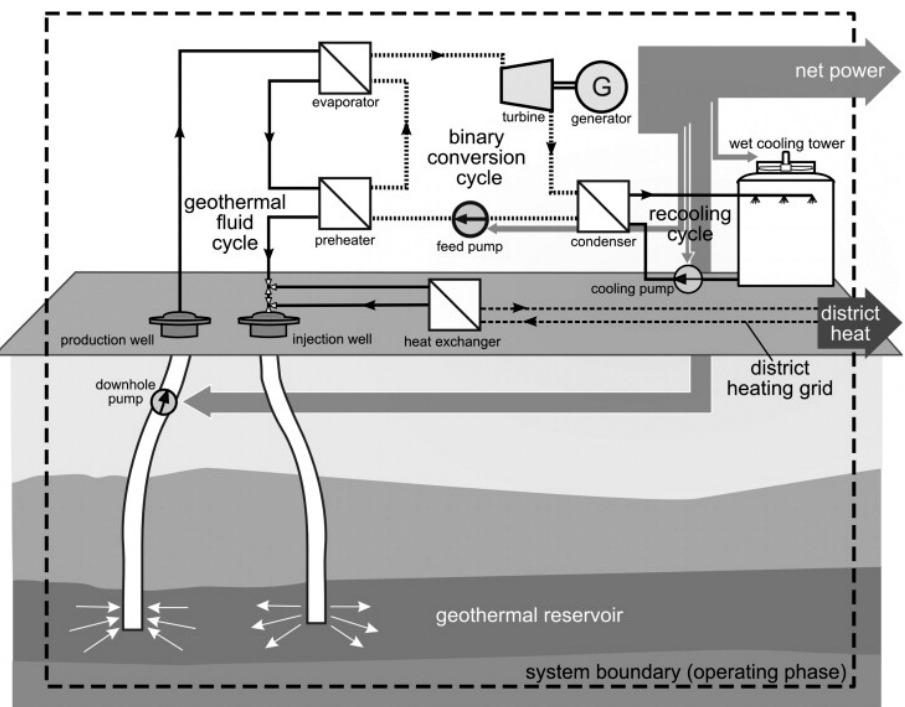
Figure 7. Plant design and system boundaries of the analyzed geothermal binary power plants exploiting a low-temperature reservoir for the supply of net power and, optionally, district heat [35].